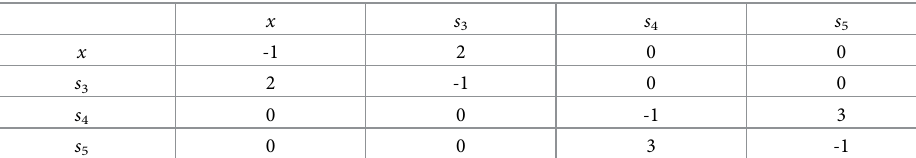
Table 3. Matrix A for posets in Fig 10 after reducing s 1 and s 2 .